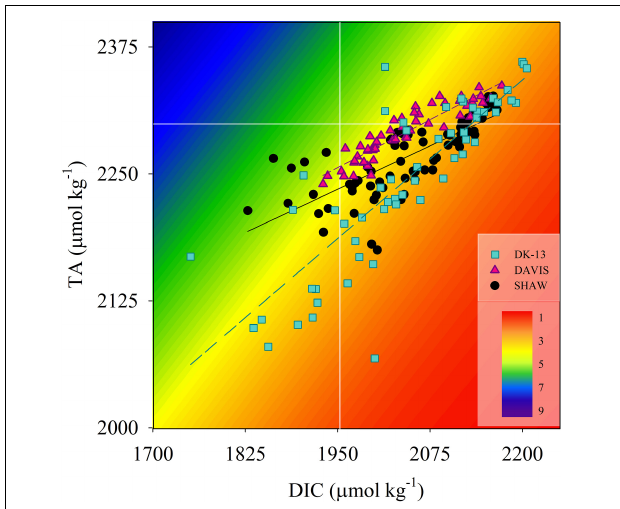
FIGURE 5 | Paired TA and DIC measurements at all sites. Background colors represent the aragonite saturation state normalized to average site temperature and salinity (McDougall and Barker, 2011). White lines represent offshore concentrations of TA and DIC as reported in Mongin et al. (2016).